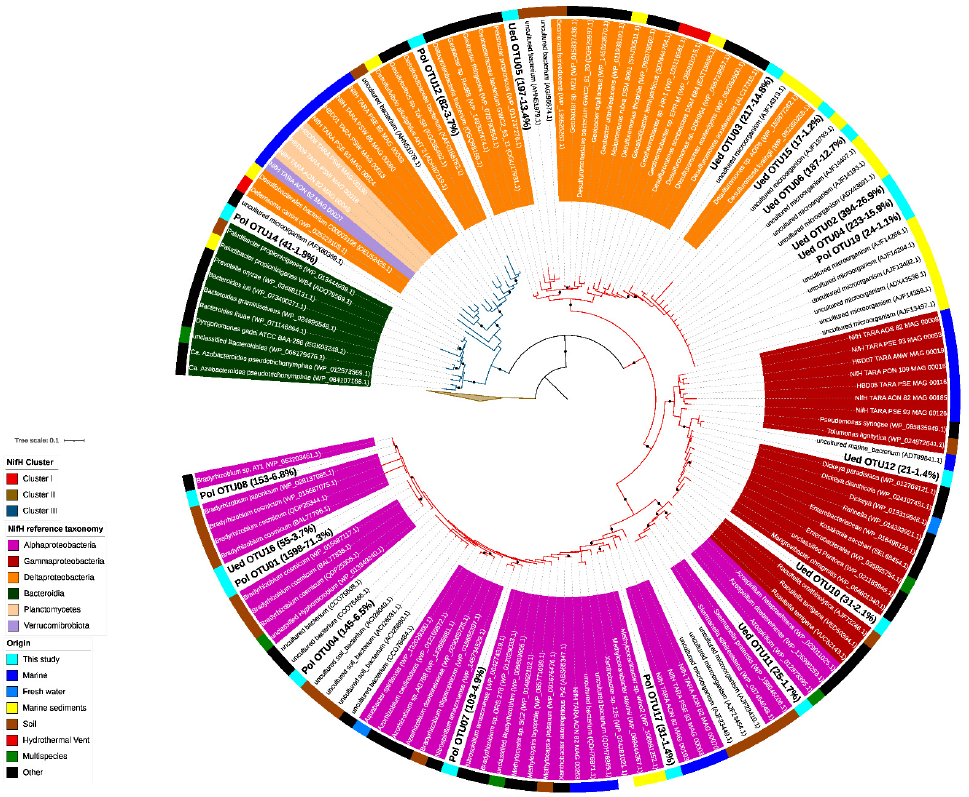
Figure 2. Phylogenetic placement of NifH protein sequences identified in coastal waters of Chile Bay. The phylogenetic placement was carried out using a maximum-likelihood phylogenetic recon- struction that included annotated reference NifH protein sequences and novel NifH protein se- quences retrieved from Tara Oceans metagenomes. Short NifH amino acid sequences are shown with a white background. NifH sequences obtained from Chile Bay are shown in bold. The number of reads assigned to each OTU, and their respective relative abundance, is shown in parenthesis (# of reads-% relative abundance). The tree was rooted to archaeal NifH sequences from Cluster II. The branch color indicates the NifH cluster, while the label background indicates the taxonomy of the NifH sequence. Black circles in the nodes indicate ≥ 95% of ultra-fast bootstrap and ≥ 80% of SH-aLRT branch support. As shown in the dendrogram (Figure 2), Chile Bay nif H OTUs were affiliated with nitrogenase clusters I (Figure 2; red branch line) and III (Figure 2; dark blue branch line). Three of the OTUs (OTU1, OTU8 and OTU4) recovered using the PolF-R primer set ac- counted for 84.6% of the total reads retrieved with this primer set. These sequences belong to Cluster I and were closely related to heterotrophic and chemoautotrophic organisms, such as Bradyrhizobium of the class Alphaproteobacteria , and methanotrophs, such as Methylocapsa, Methyloceanibacter, Methylocystis and Xanthobacter (Figure 2; purple, Supple- mentary Table S1), which have been previously widely detected elsewhere in soil (outer ring, brown) and marine (blue) samples. OTUs retrieved with the second primer set